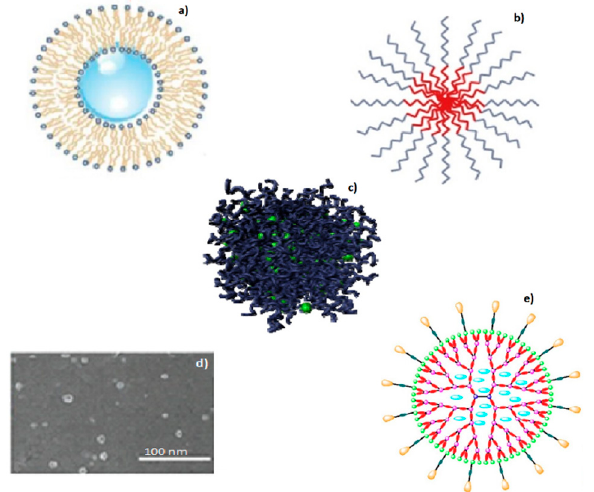
Figure 2. Schematic depicting examples of nanosized delivery systems; ( a ) liposomes, ( b ) nanomicelles, ( c , d ) polymer–drug conjugates, and ( e ) dendrimers, which are currently explored in detail for transport of chemotherapeutic agents (adapted with permission from ( a ) Trucillo et al. [31], ( b ) Brandta et al. [51], ( c , d ) Tong et al. [52], ( e ) Huang &Wu